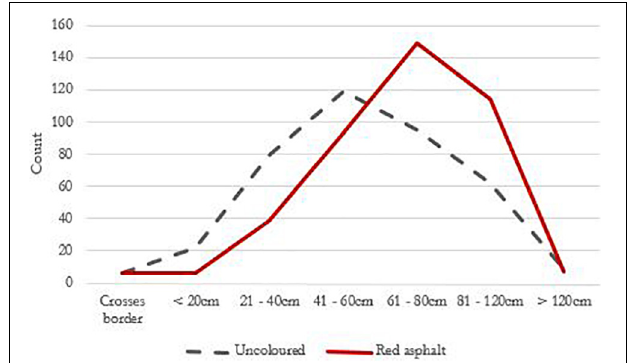
FIGURE 2 | Distribution of motorists’ distance to cycle lane border before and after.